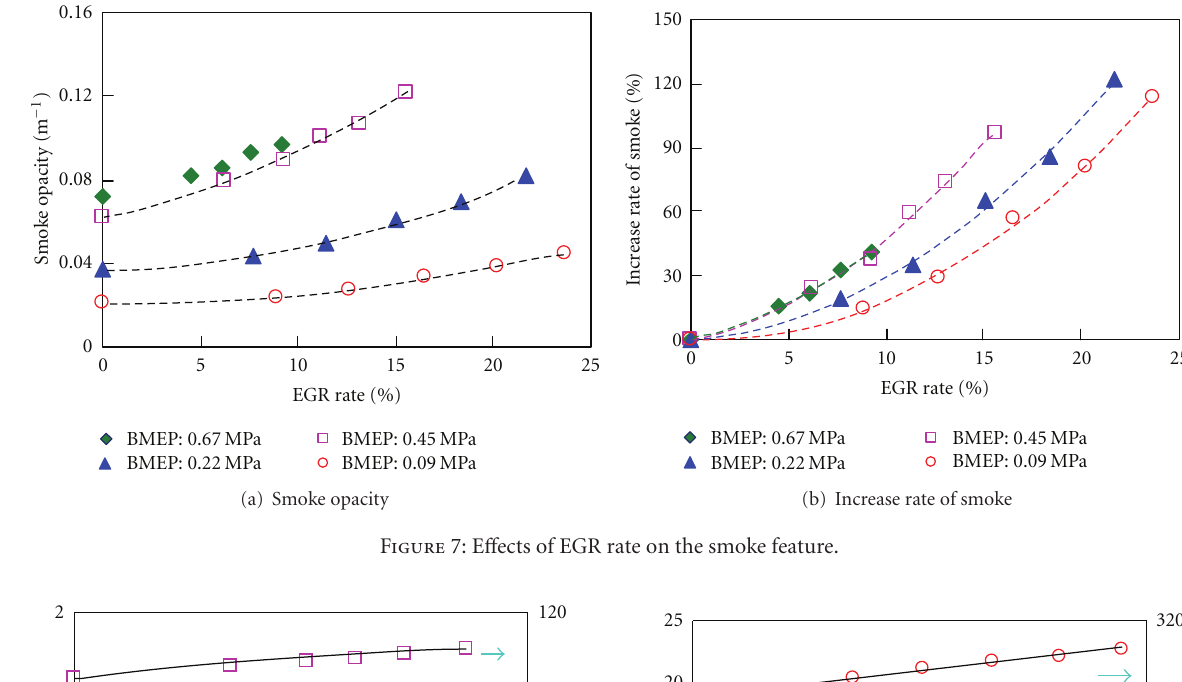
Figure 7: E ff ects of EGR rate on the smoke feature.